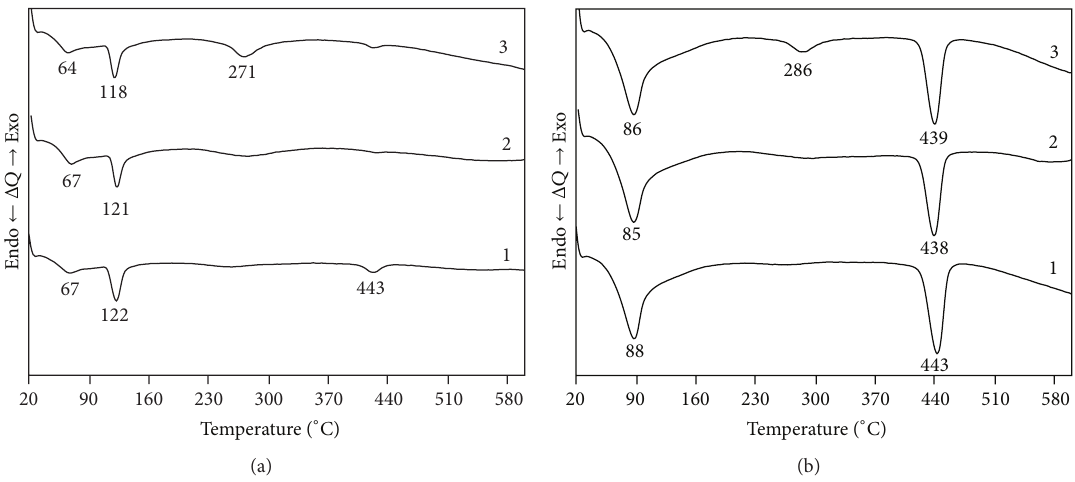
Figure 2: DSC curves OPC with 10 wt.% additive after 1.8h (a) and 16.5 h (b): 1, OPC; 2, OPC-CAH1; 3, OPC-CAH2.